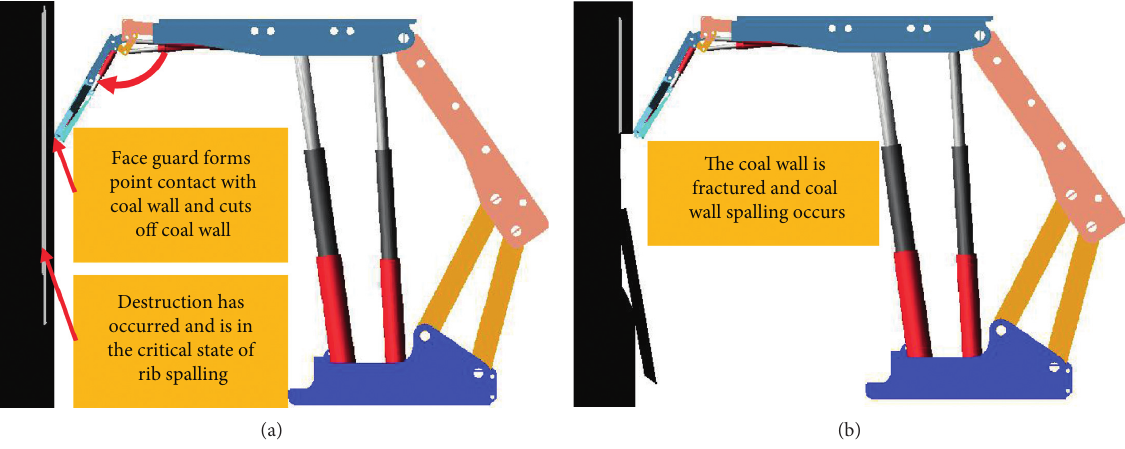
Figure 4: Schematic of the coal wall cutting by face guard.